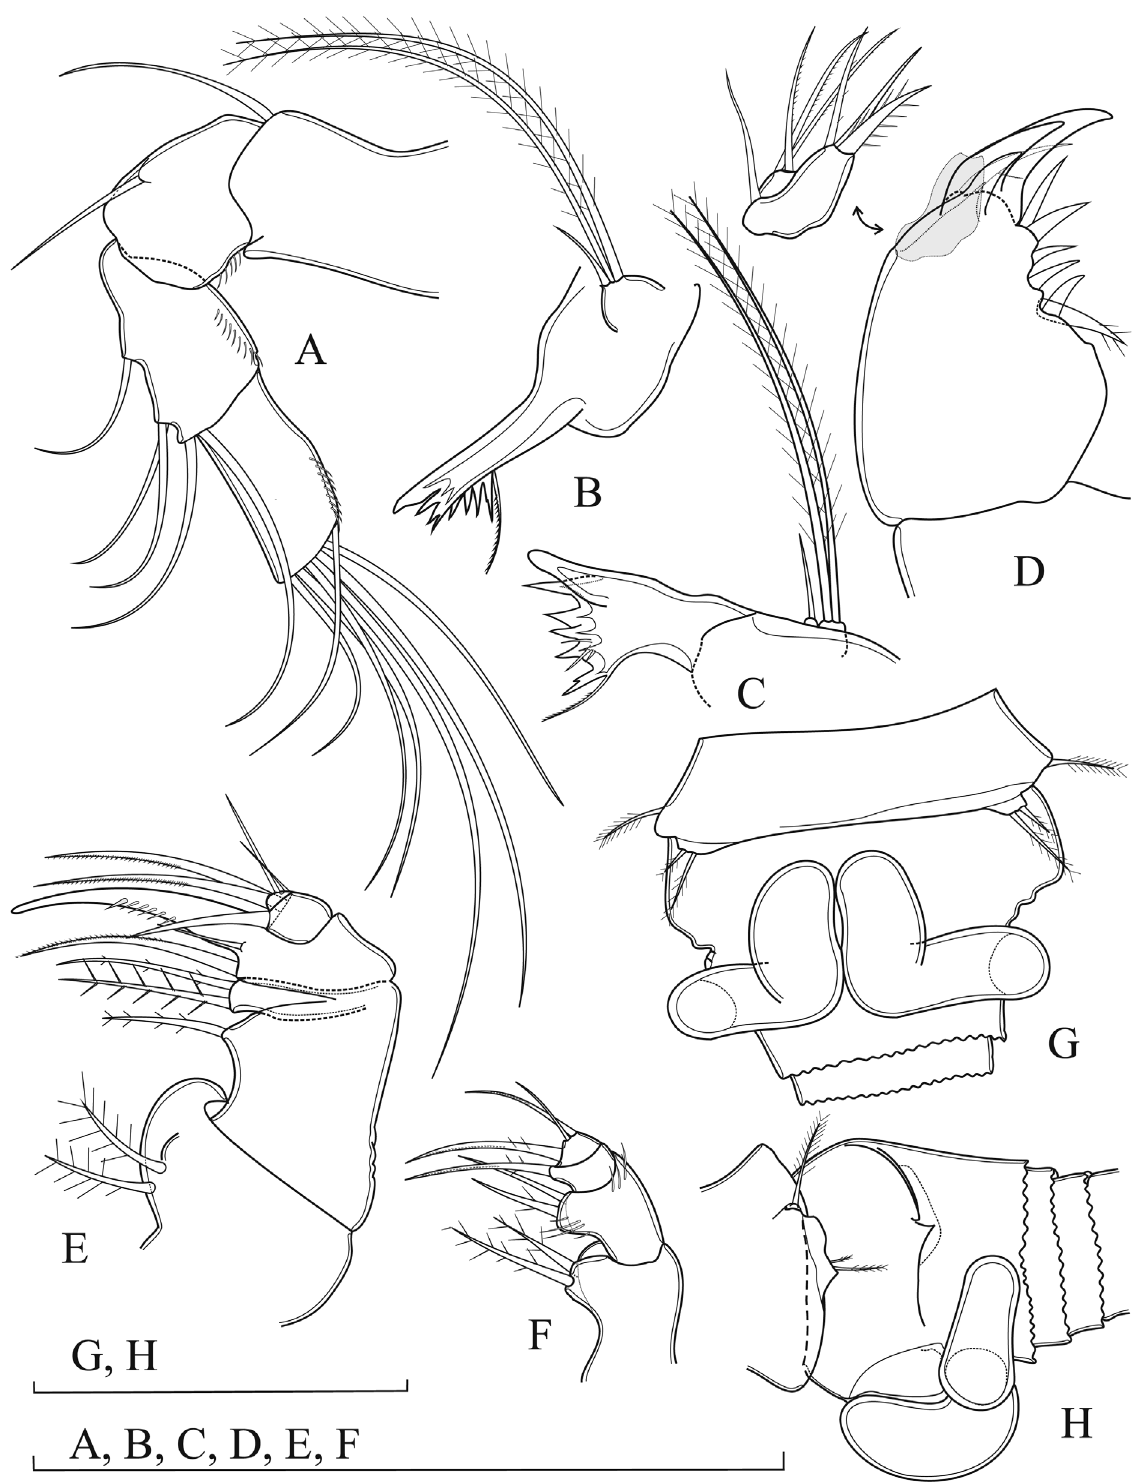
Fig. 2. Siamcyclops cavernicolus gen. et sp. nov., holotype, ♀. A . Antenna. B–C . Mandible. D . Maxillule. E . Maxilla. F . Maxilliped. G . Genital double-somite with spermatophore, ventral view. H . Genital double-somite with spermatophore, lateral view. Scale bars: 100